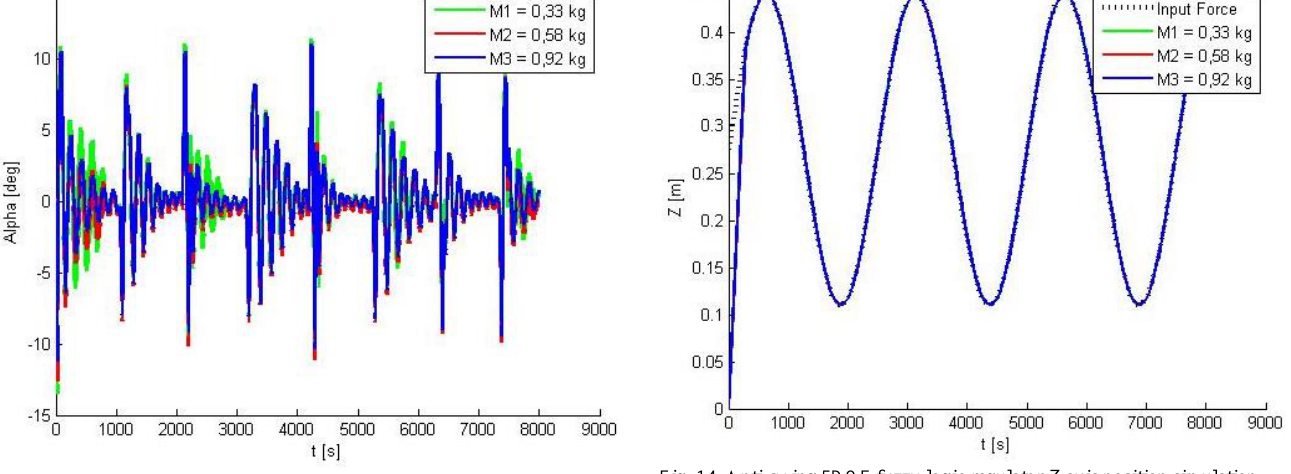
Fig. 11. Anti-swing 5DOF PI regulator  angle of the payload oscillation simulation results.